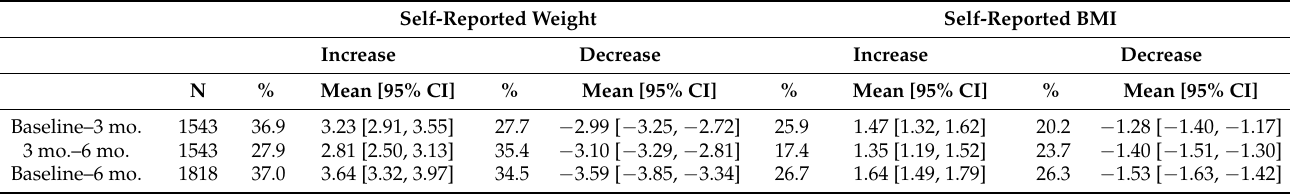
Table 2. Unweighted proportions increasing or decreasing weight/BMI, and mean changes in proportions increasing or decreasing weight/BMI with 95% confidence intervals.